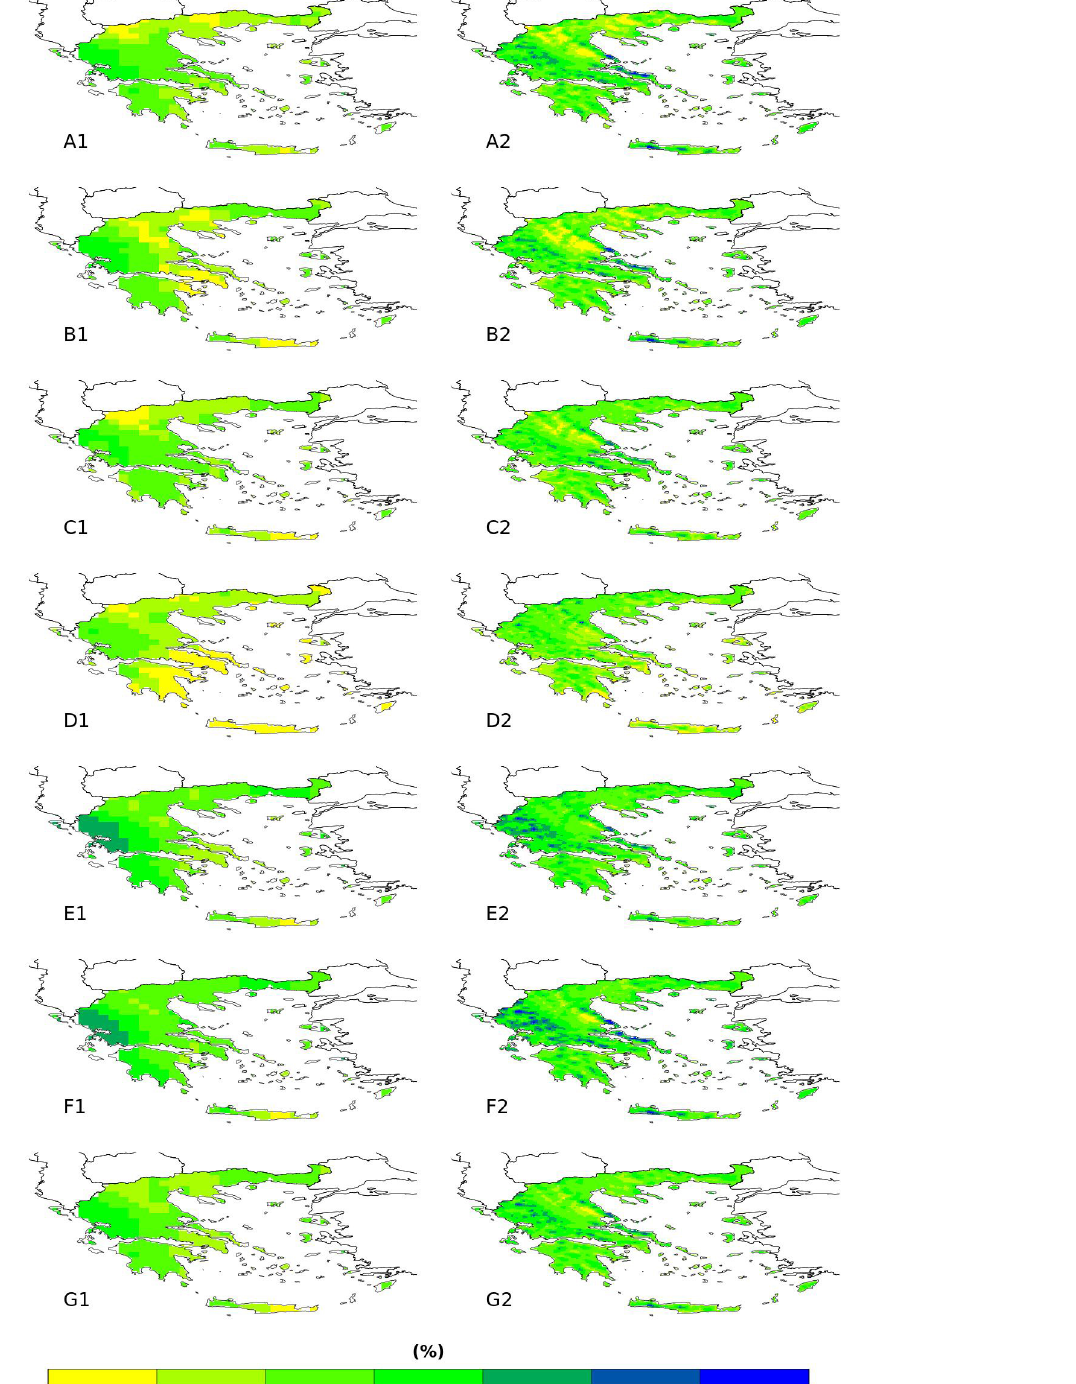
Figure C1. RR20 probabilities spatial distribution for (1) ERA5 and (2) WRF_5 for the months (a) January, (b) February, (c) March, (d) April, (e) November, (f) December and (g) for the entire season